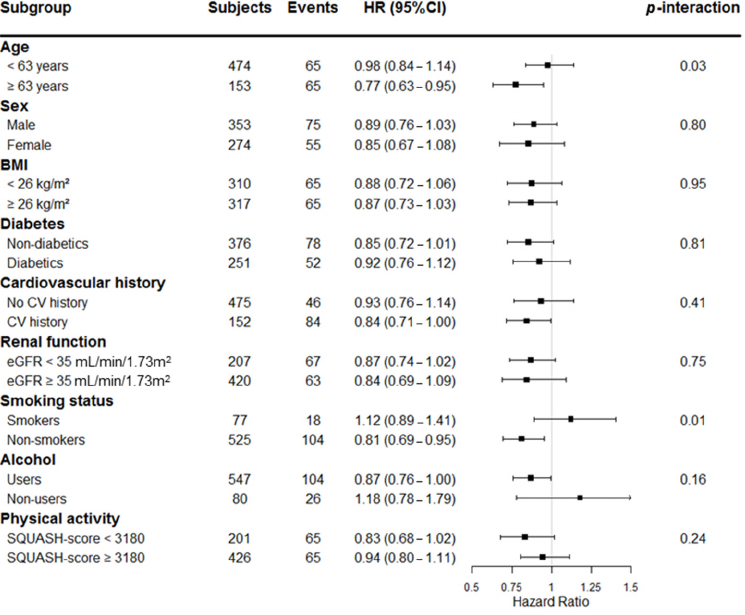
Figure 1. Stratified ‐ analysis of the association of EPA ‐ DHA intake with all ‐ cause mortality in RTR. Hazard ratios adjusted for age and sex are shown. Subgroups with p ‐ interaction < 0.05 were considered effect modifiers on the association of EPA ‐ DHA intake with all ‐ cause mortality.